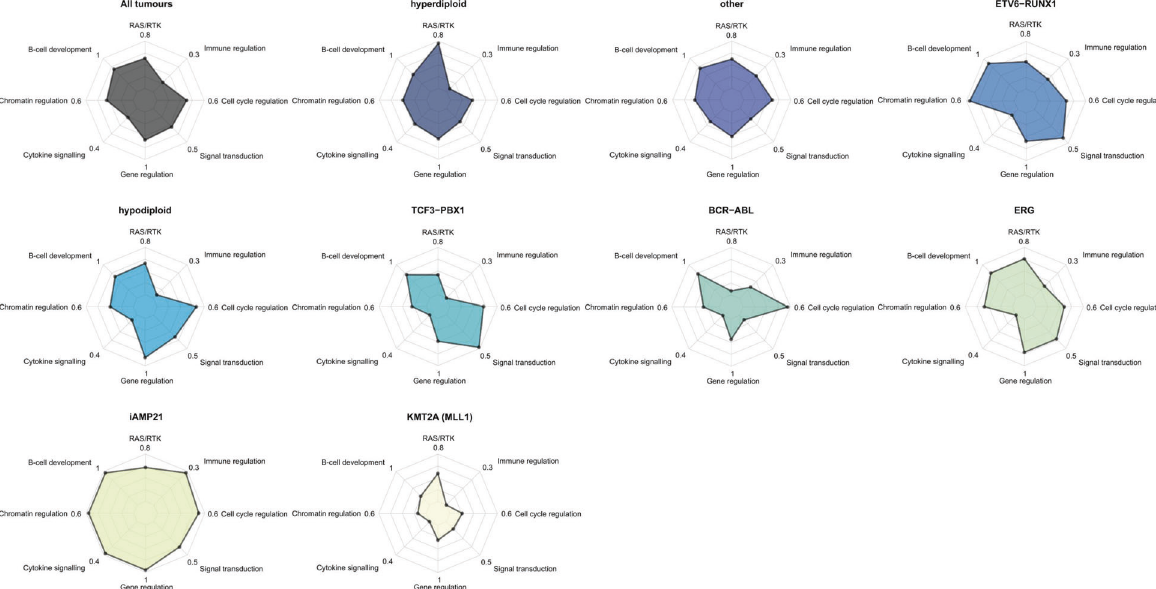
Fig. 5 Pathway analysis and signature analysis. Radar plots showing the most frequently altered pathways for each subtype. Driver genes grouped according to the biological pathway. Somatic alterations for a selected ALL driver genes was compiled from SNV, indel, CNV, SV, RNAseq, and LOH data (CNVs include only focal events). Subtype de fi ning events are excluded (e.g, disruption of ETV6 or RUNX1 in ETV6- RUNX1 positive tumours). The proportion of tumours with an alteration in any gene assigned to that pathway is plotted on the radial axis. Each axis is scaled separately. Gene — pathway assignments: RAS/RTK; NRAS, KRAS, PTPN11, FLT3, NF1, ABL1 . B-cell development; PAX5, IKZF1, ETV6, ZEB2, RUNX1, TCF3, RAG1, RAG2, EBF1 . Chromatin regulation; SETD2, HDAC7, NSD2, CTCF, KMT2A, STAG2 , histone gene cluster 1. Cytokine signalling; JAK2, IL7R, CRLF2 . Gene regulation; CREBBP, MLLT1, MLLT3, AFF1, BTG1, ERG, TCF4, NCOA6 . Signal transduction; TBL1XR1, TBL1X, PBX1, PAG1 . Cell cycle regulation; CDKN2A, CDKN2B, RB1 . Immune regulation; BTLA, HLA-DRB5